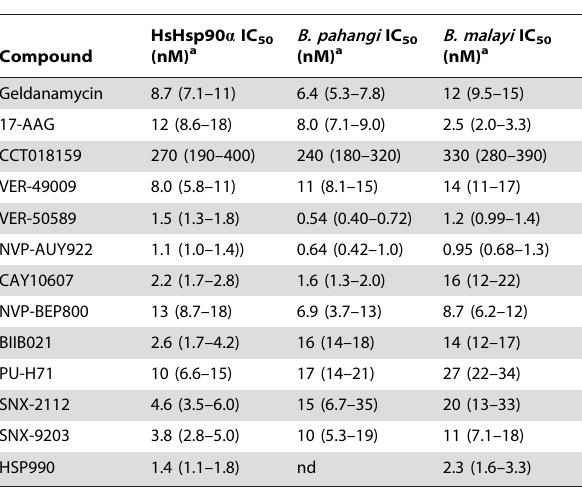
Table 2. Binding affinity of various Hsp90 inhibitors versus human Hsp90 a , B. pahangi and B. malay i Hsp90 in the FP